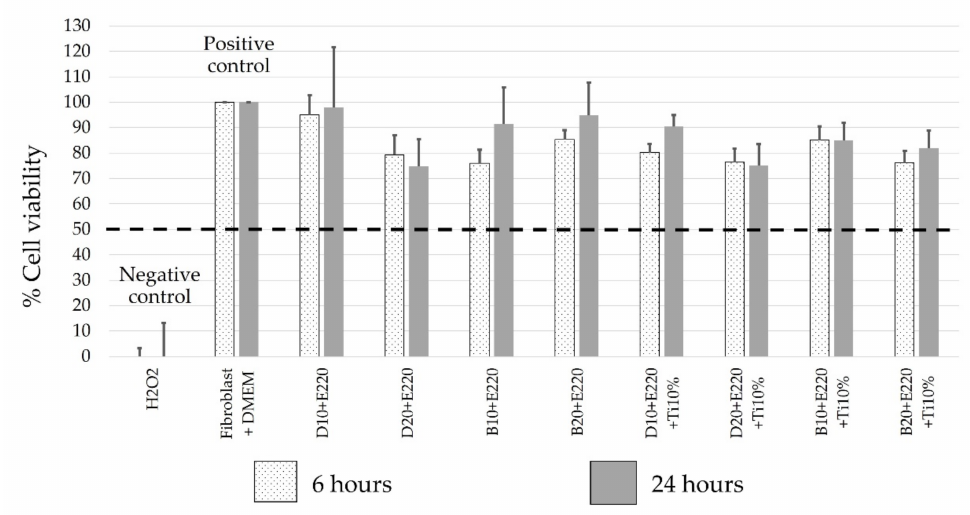
Figure 5. Comparison of percentage of human gingival fibroblast viability among 8 test photosensi- tizers, which includes 10/20 µ M curcumin derivatives, and 220 µ M erythrosine with/without 10% nano-titanium dioxide (by mass) in photodynamic therapies after 6 and 24 h, via PrestoBlue ® vitality assay. DMEM and H 2 O 2 were used as the positive and negative control, respectively. Kruskal–Wallis with Dunn post hoc tests were performed to observe the significant differences among the exper- imental groups ( p < 0.05), ( n = 9). The dashed line shows the level of 50% viability, proposed by Bugelski et al.